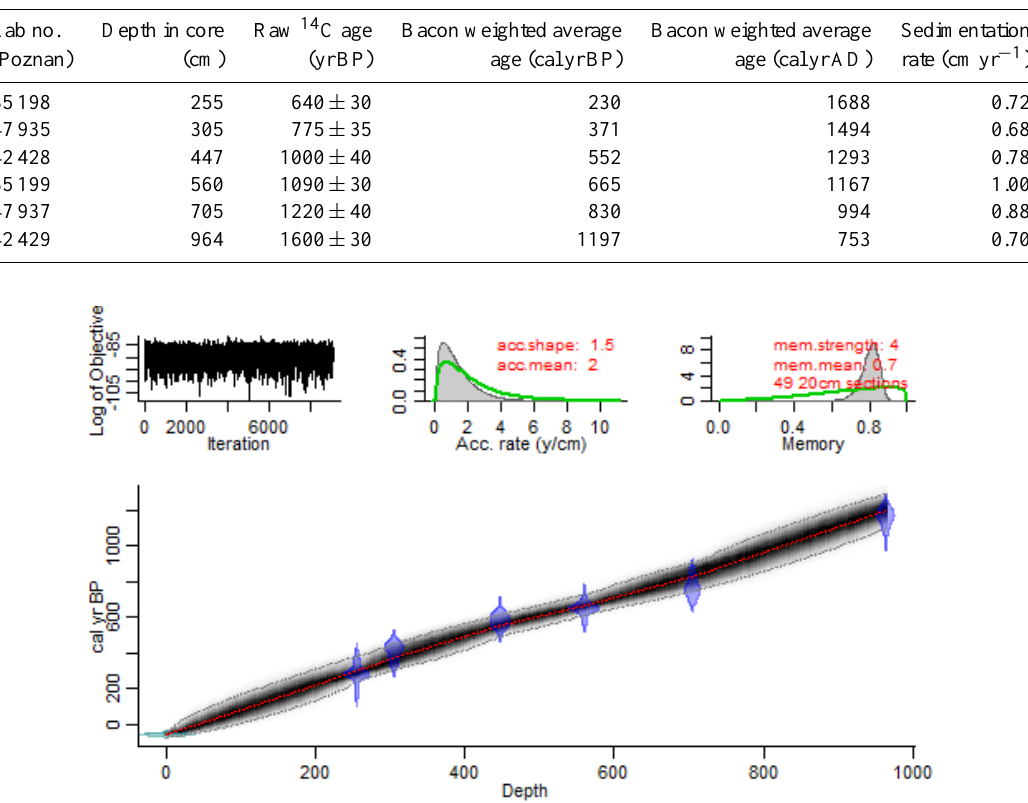
Figure 2. The age–depth model for core GeoB 13813-4 using the program Bacon. Upper panels depict the Markov chain Monte Carlo (MCMC) iterations (left), the prior (green curves) and posterior (grey histograms) distributions for the sedimentation rate (middle panel) and memory (right panel). The bottom panel shows the calibrated 14 C dates (transparent blue), extraction year of the core ( − 59yrBP, AD2009, transparent light blue) and the age–depth model (grey stippled lines indicate the 95% confidence intervals; the red curve shows the “best” fit based on the weighted mean age for each